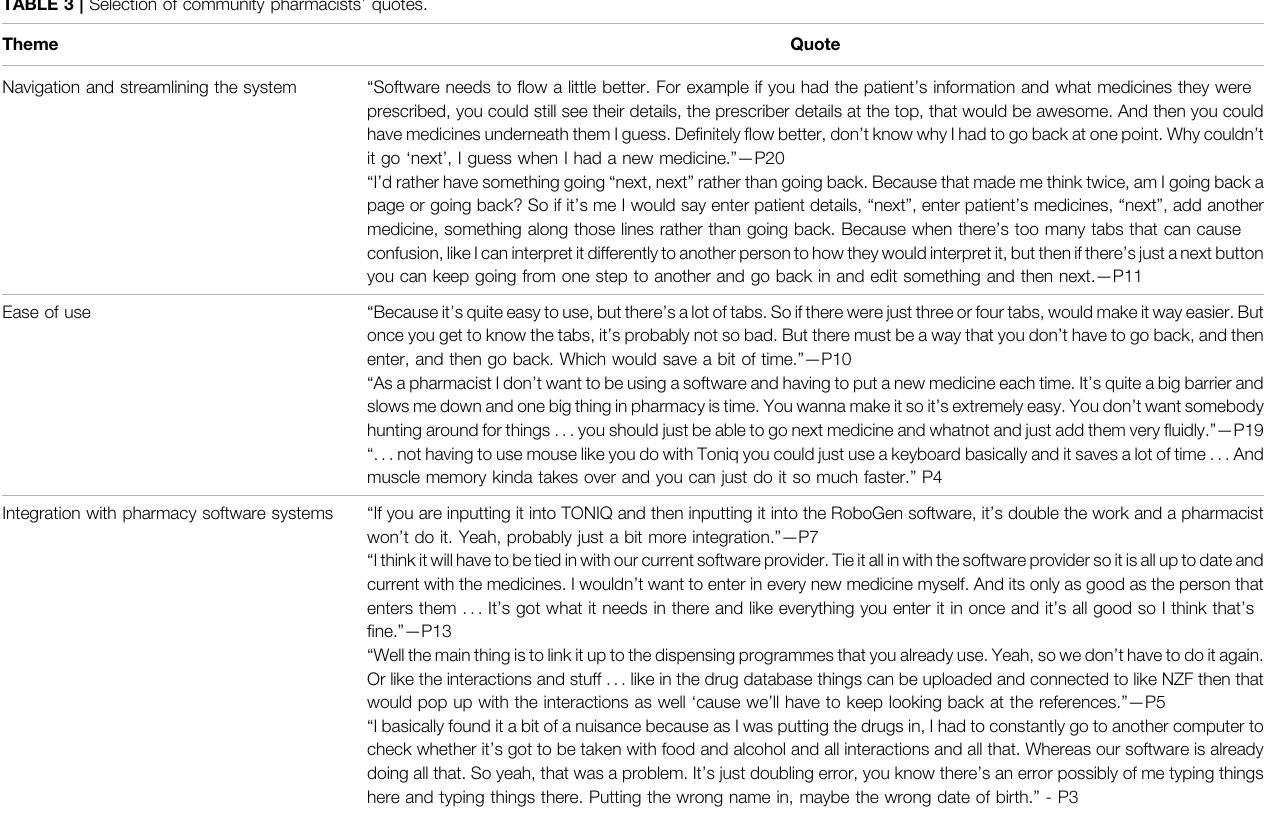
TABLE 3 | Selection of community pharmacists ’